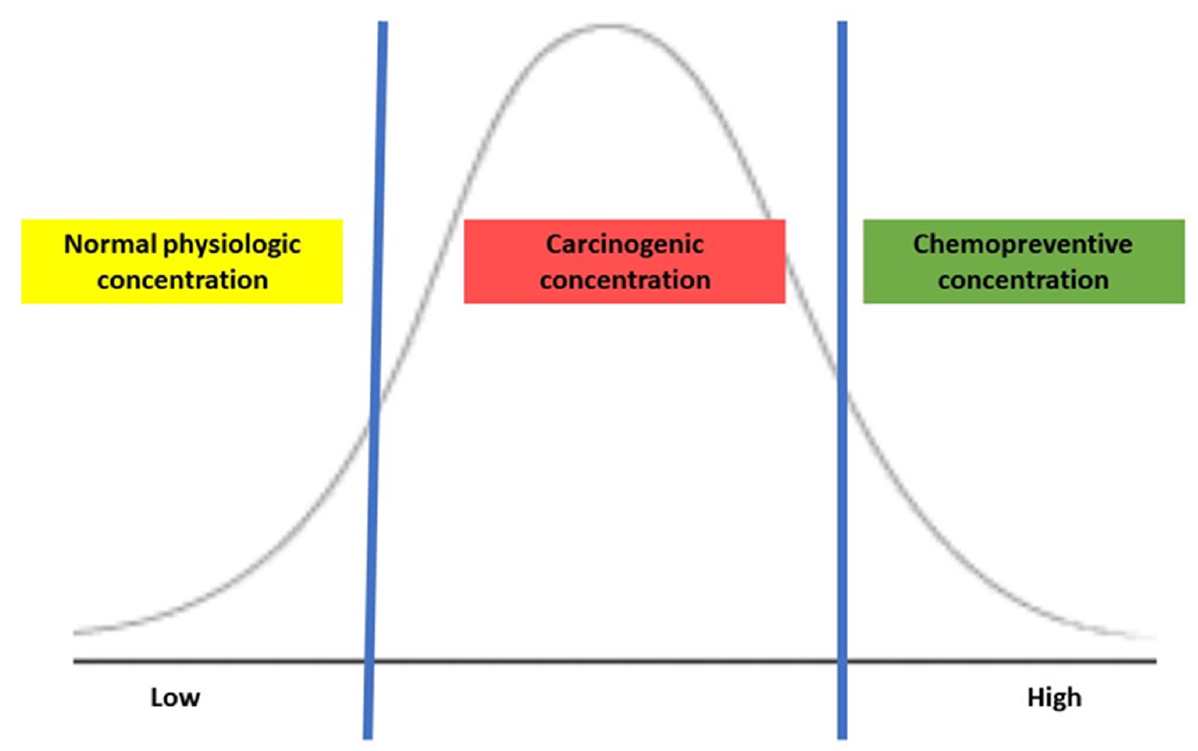
Figure 6. The action of H 2 S is based on its Figure 6 . The action of H 2 S is based on its concentration .